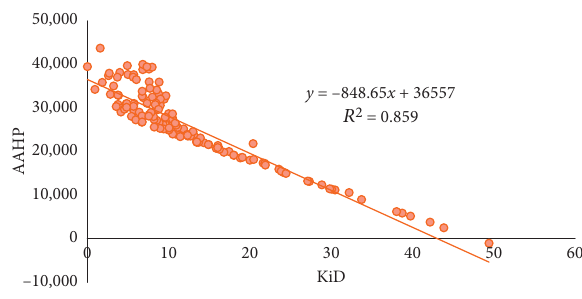
Figure 9: The line fit plots of K D